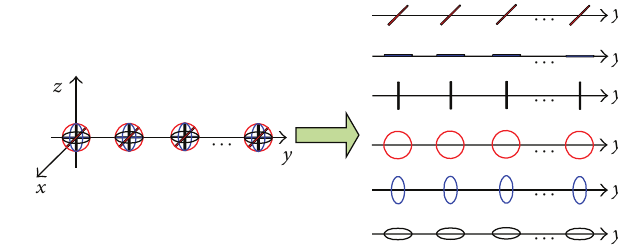
Figure 2: Six spatially identical subarrays offered by EMVS